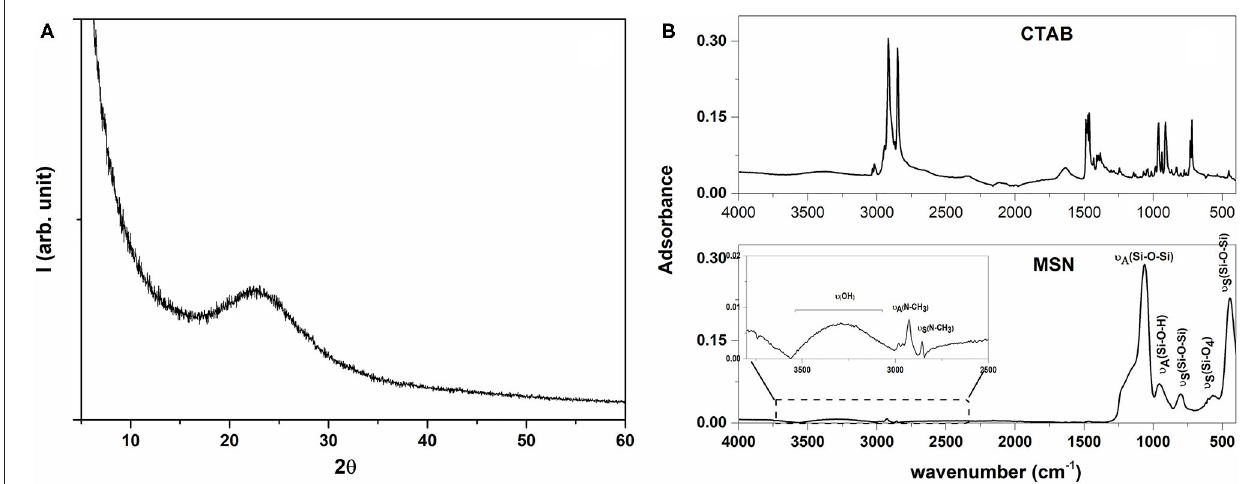
FIGURE 1 | XRD pattern (A) of synthesized MSN and FT-IR spectra (B) of CTAB and of synthesized